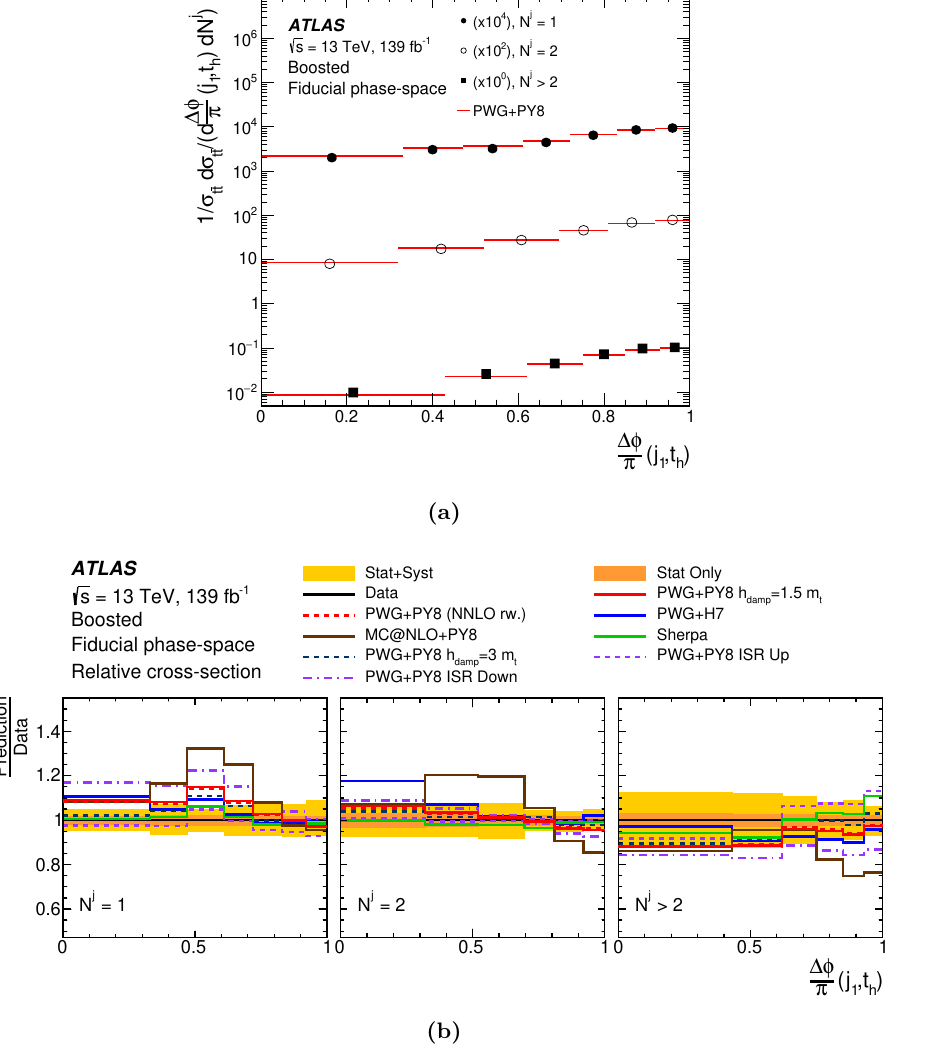
Figure 29. (a) Normalised differential cross-section measurements as a function of the ∆ φ angle between the leading additional jet and the hadronically decaying top quark in bins of additional jet multiplicity are compared with the prediction from the Powheg+Pythia MC generator. The measurement and the predictions are further normalised by the factors shown in parentheses to aid visibility. (b) Ratio of the measured normalised cross-section to different NLO, and NLO reweighted to NNLO, predictions of t ¯ t signal for the same differential variables. PWG+PY8 corresponds to the Powheg+Pythia sample, PWG+H7 to the Powheg+Herwig sample and MCatNLO+PY8 to the MadGraph5_aMC@NLO+Pythia sample. The yellow band represents the total uncertainty of the measured differential cross-section while the orange band shows the statistical